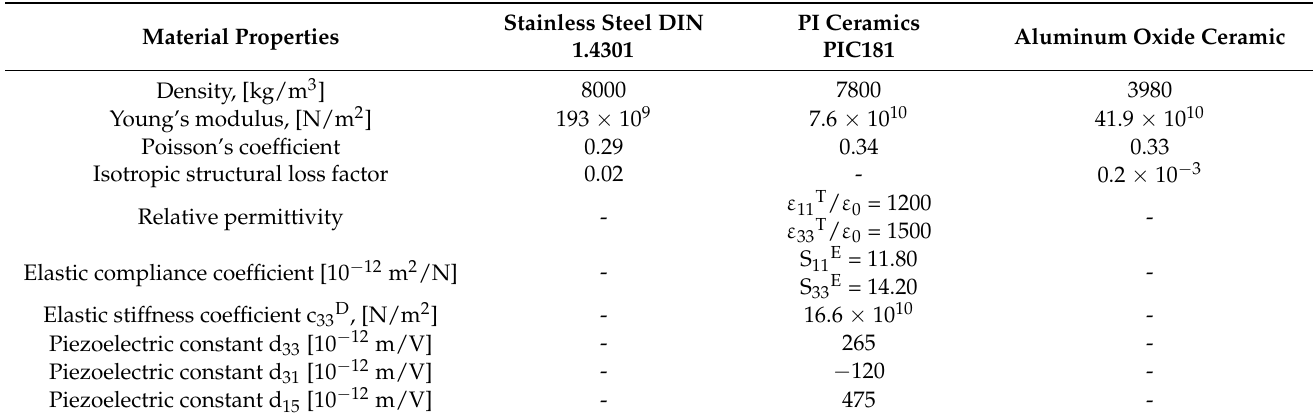
Table 3. Materials properties used in the model.